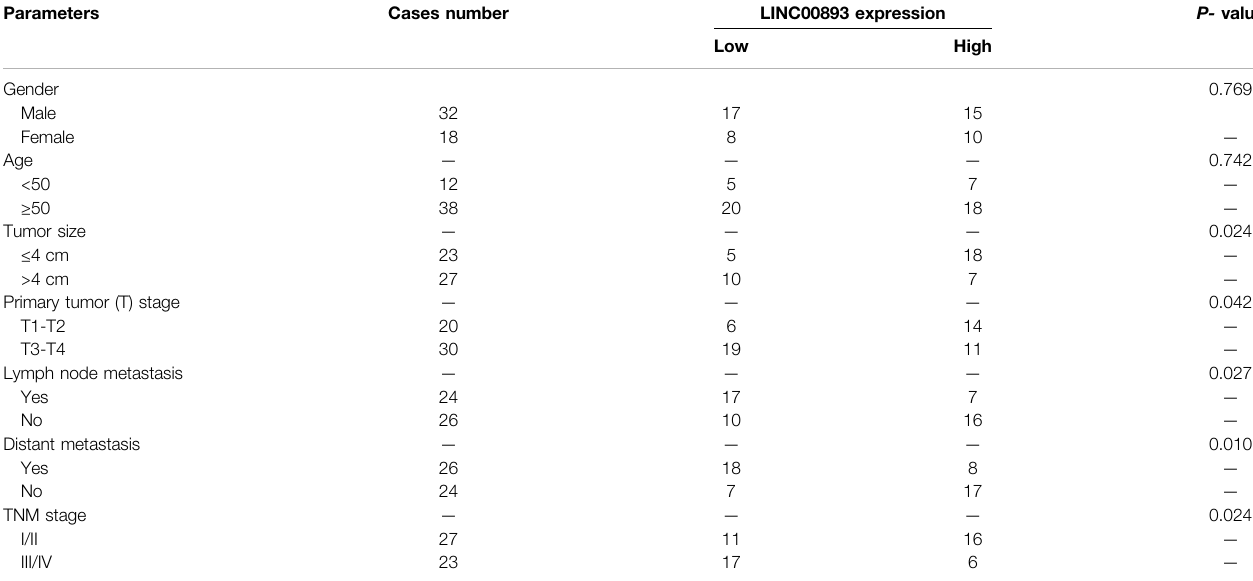
TABLE 1 | Correlation between LINC00893 expression and clinicopathological characteristics in GC patients.